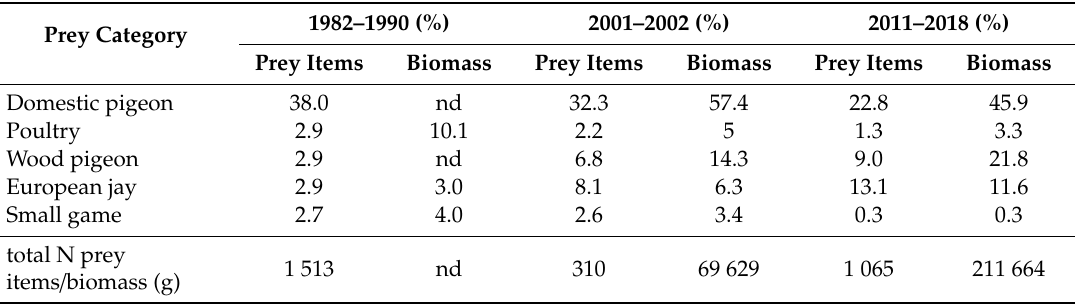
Table 5. The share of selected prey categories in the goshawk diet in the area of study (central Poland, vicinity of Rog ó w village, Experimental Forest Station of Warsaw University of Life Sciences) in the three compared breeding periods: Small game included pheasant, grey partridge, brown hare, and European rabbit. The data are for 1982–1992 [29], 2001–2002 [31], and 2011–2018, the current study. Nd: no data available.